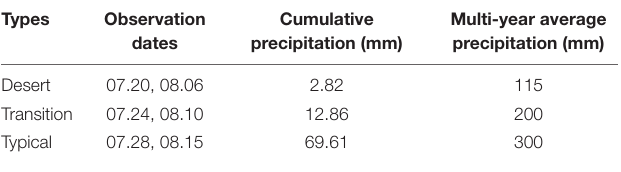
TABLE 1 | The observation date and its cumulative precipitation for each